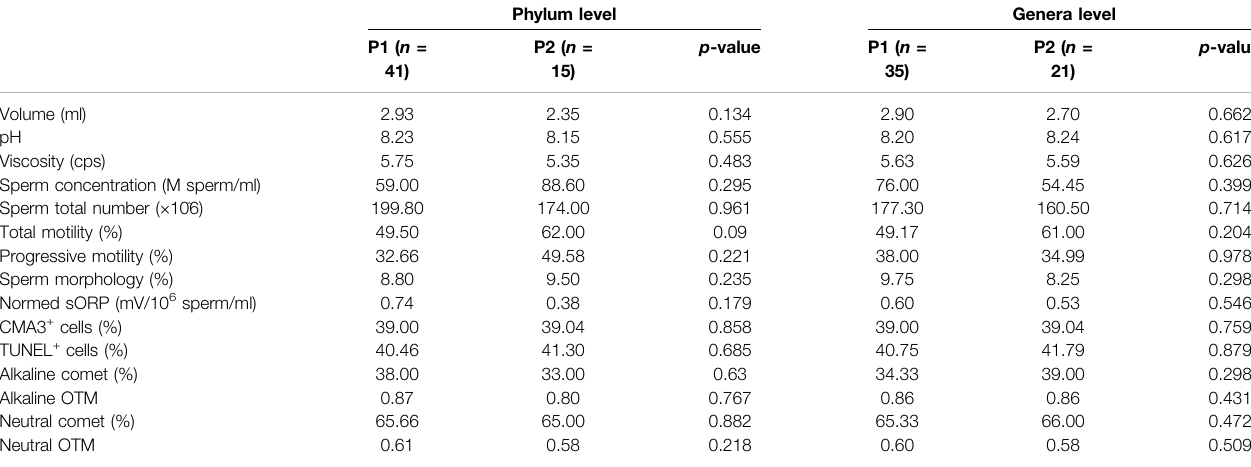
TABLE 2 | Comparative study of seminal and sperm parameters (Mann-Whitney ’ s U) between microbiome pro fi le 1 (P1) and pro fi le 2 (P2) at phylum and genera